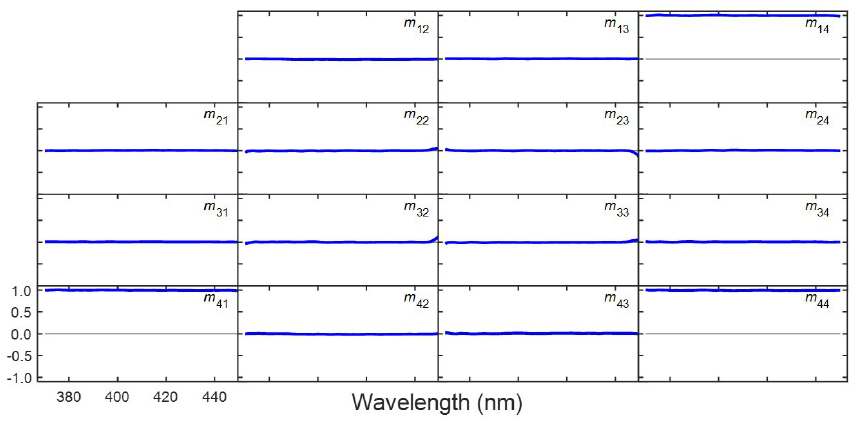
Figure 11. Transmission Mueller matrix of the ChGLC sample in the Bragg